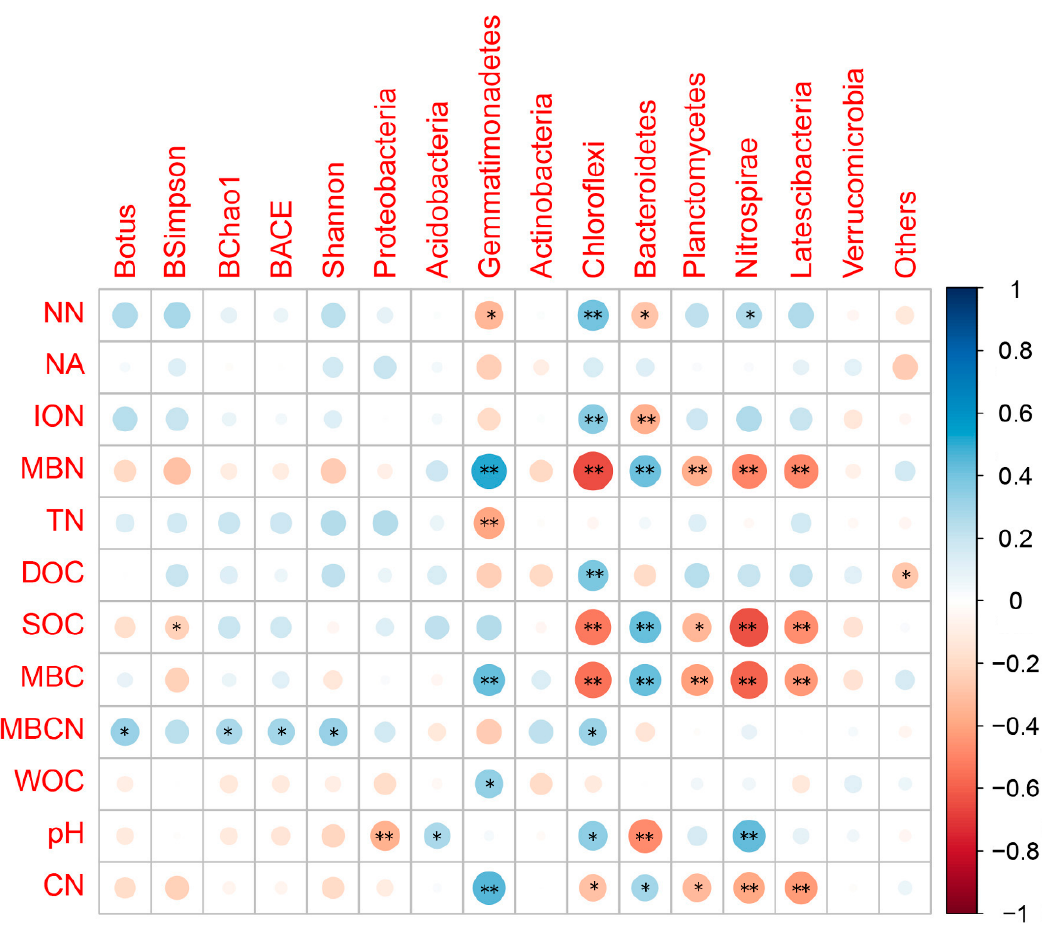
Figure 6. Correlation between soil nitrogen and carbon components and bacterial community structure. Capital letters on the ordinate represent soil nutrients. NN, nitrogen-N; NA, ammonium-N; AN, soil inorganic nitrate; ION, rate of nitrogen to ammonium; TN, total nitrogen; MBN, microbial biomass nitrogen; DOC, dissolved organic carbon; SOC, soil organic carbon; DSC, rate of DOC to SOC; IC, soil inorganic carbon; MBC, microbial biomass carbon; MBCN, rate of MBC to MBN; WOC, soil moisture; pH, soil pH; CN, Rate of SOC to TN. The abscissa letters indicate the Alpha diversity communities and relative abundance of soil bacteria at the phylum level. B OTU, the operational taxonomic unit of soil bacteria; B Simpson , Simpson index of soil bacteria; B Chao1 , Chao1 index of soil bacteria; B ACE, ACE estimator of soil bacteria; B Shannon , Shannon index of soil bacteria. And other was bacterial community structures at the phylum level. Blue indicate the positive effects; and red indicate the negative effects. “**”, correlation is signification at the p < 0.01 level, “*” correlation is signification at the p < 0.05